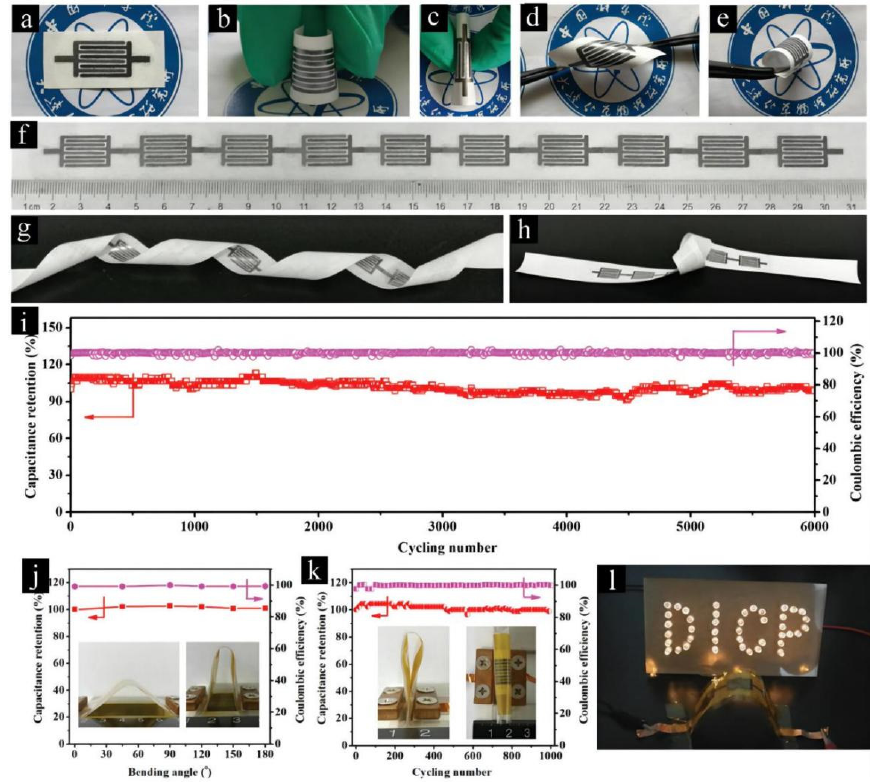
Figure 8. ( a – h ) Images of LIMCs (in series) in flat, bending, twisted and circled, spiral and knotted states. ( i ) Cycling stability of LIMCs for 6000 cycles. ( j ) Capacitance retention as a function of the bending angles. ( k ) Cycling stability in the state of a circle shape. ( l ) Images of the DICP logo powered by three in-series LIMCs under bending. Reprinted with permission from [92]. Copyright Elsevier Publisher, 2022.